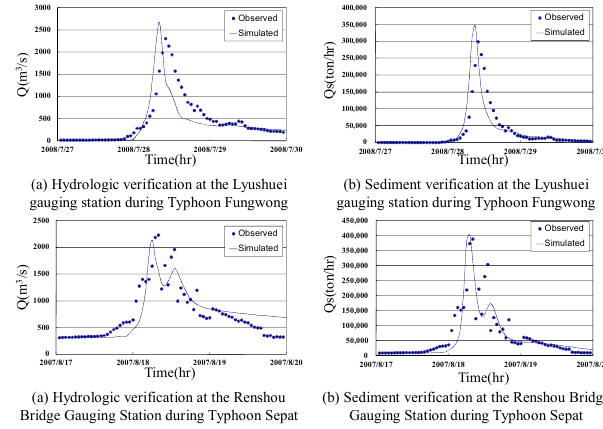
Figure 7. Verification results for both streamflow and sediment discharge simulation. 613 Fig. 7. Verification results for both streamflow and sediment dis- charge